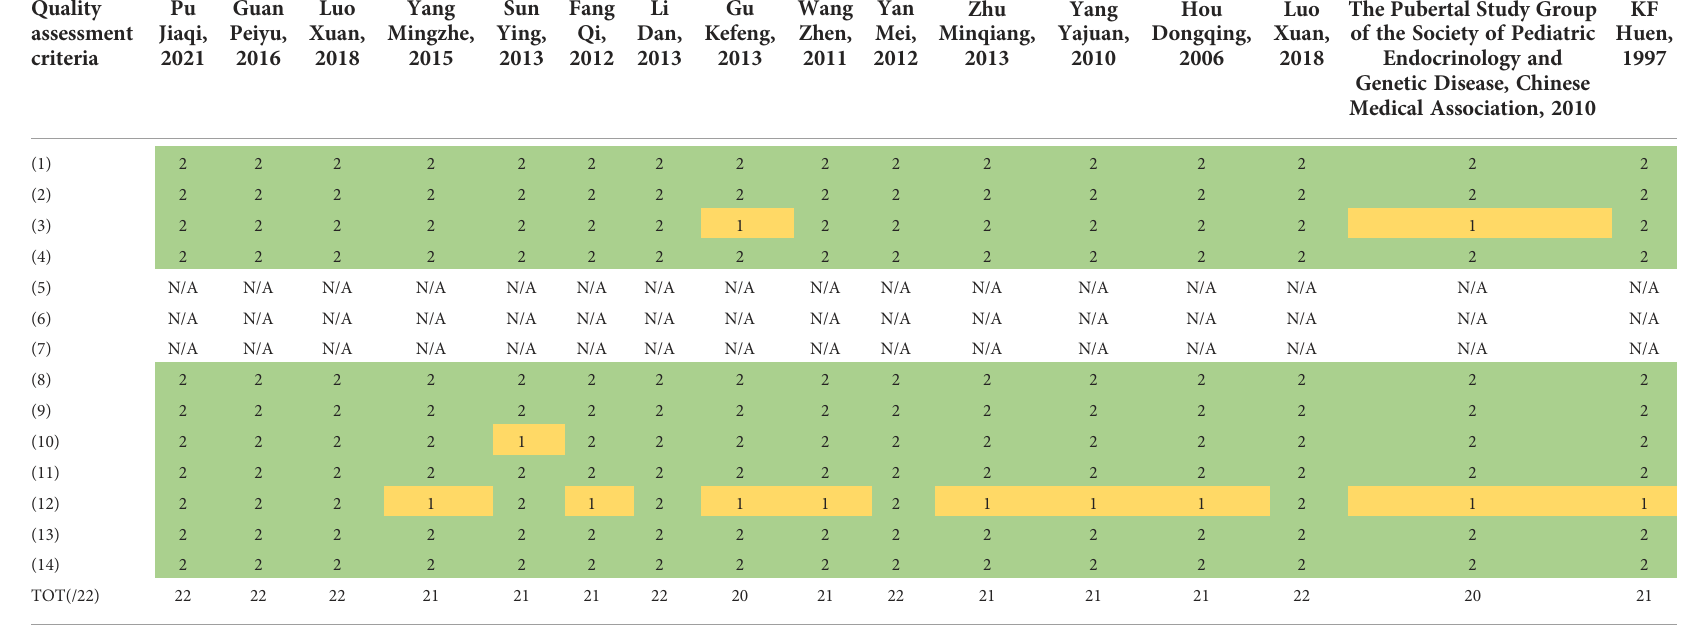
TABLE 1 Literature quality asssement tool: QualSyst tool. Quality assessment